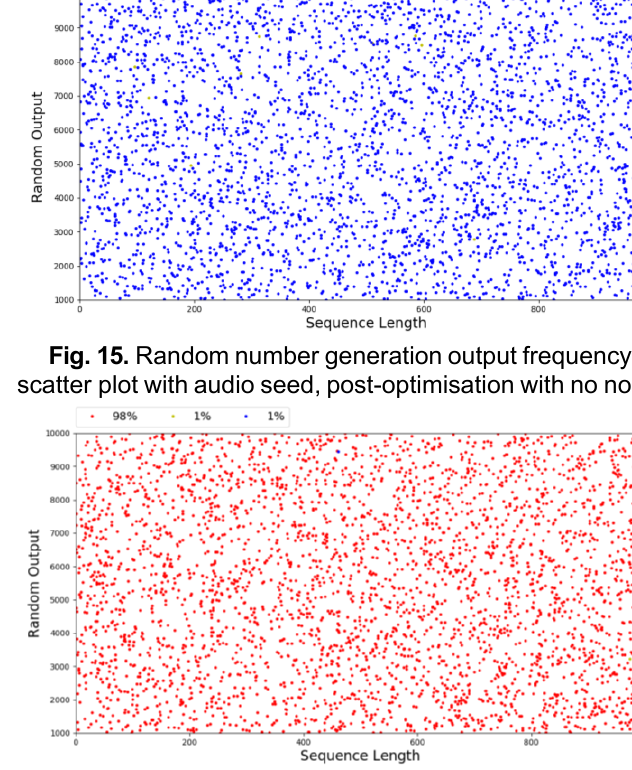
Fig. 13. Random number generation output frequency scatter plot with audio seed, pre-optimisation with noise